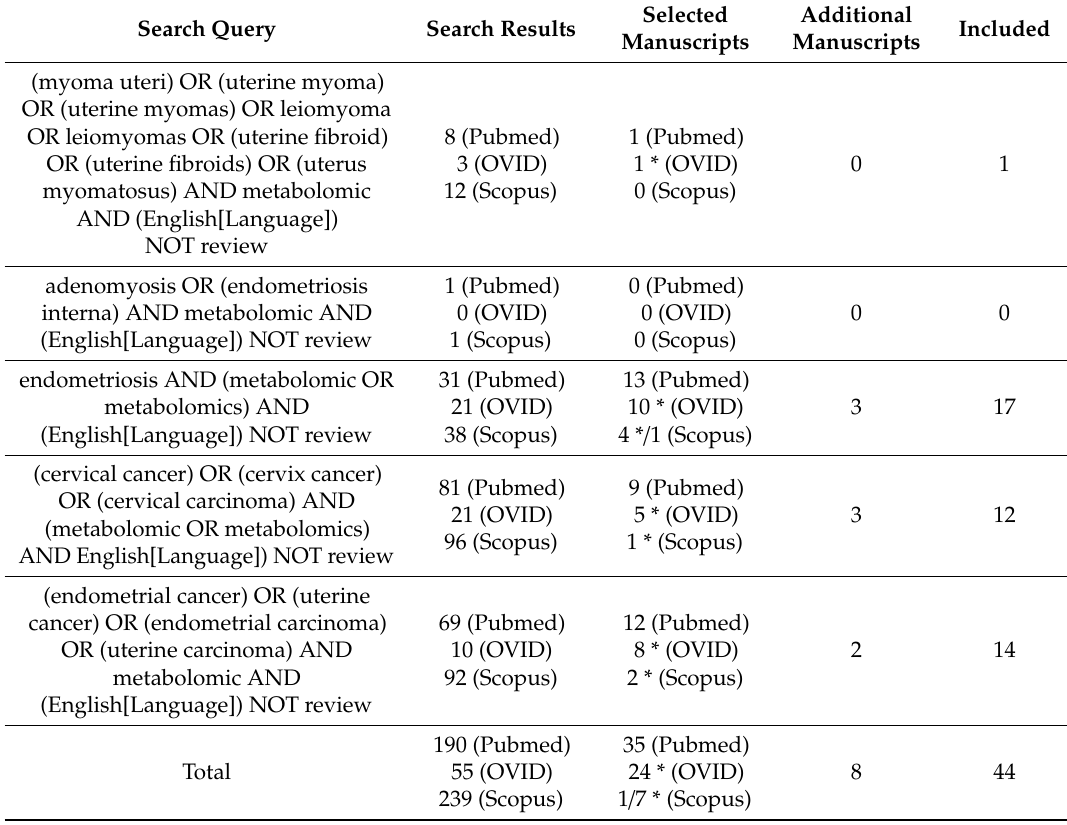
Table 1. Search strategy for identification of manuscripts in Pubmed, OVID, and